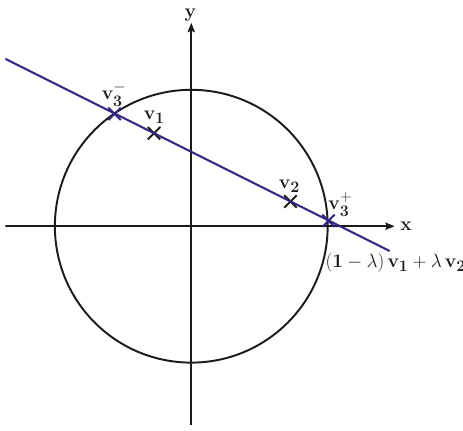
is chosen as one of 3